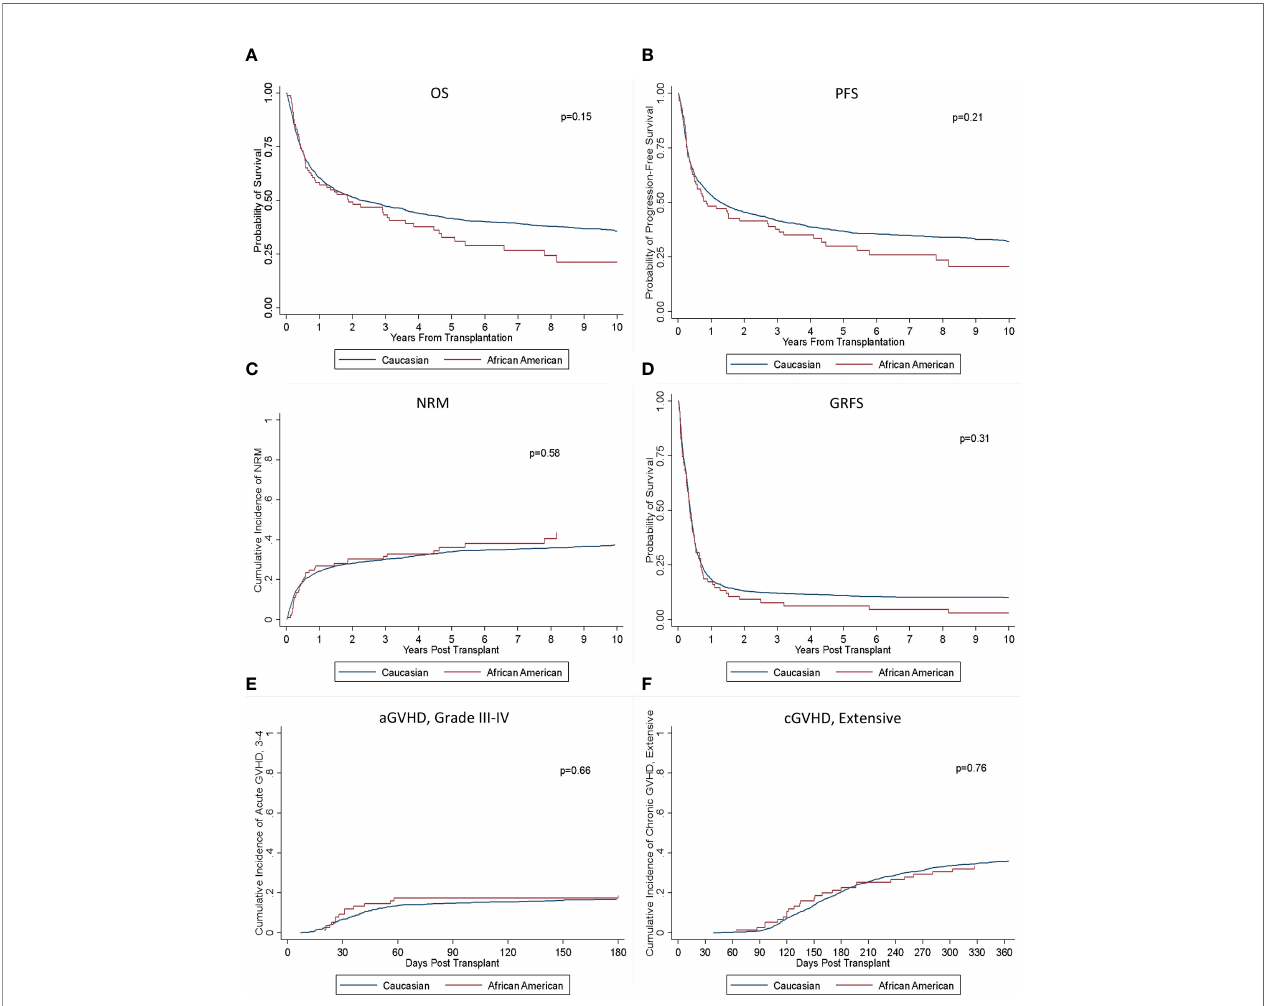
FIGURE 1 | Outcomes based on race. There was no signi fi cant difference in (A) OS, (B) PFS, (C) NRM, (D) GRFS, (E) aGVHD III-IV, or (F) cGVHD (extensive) between the